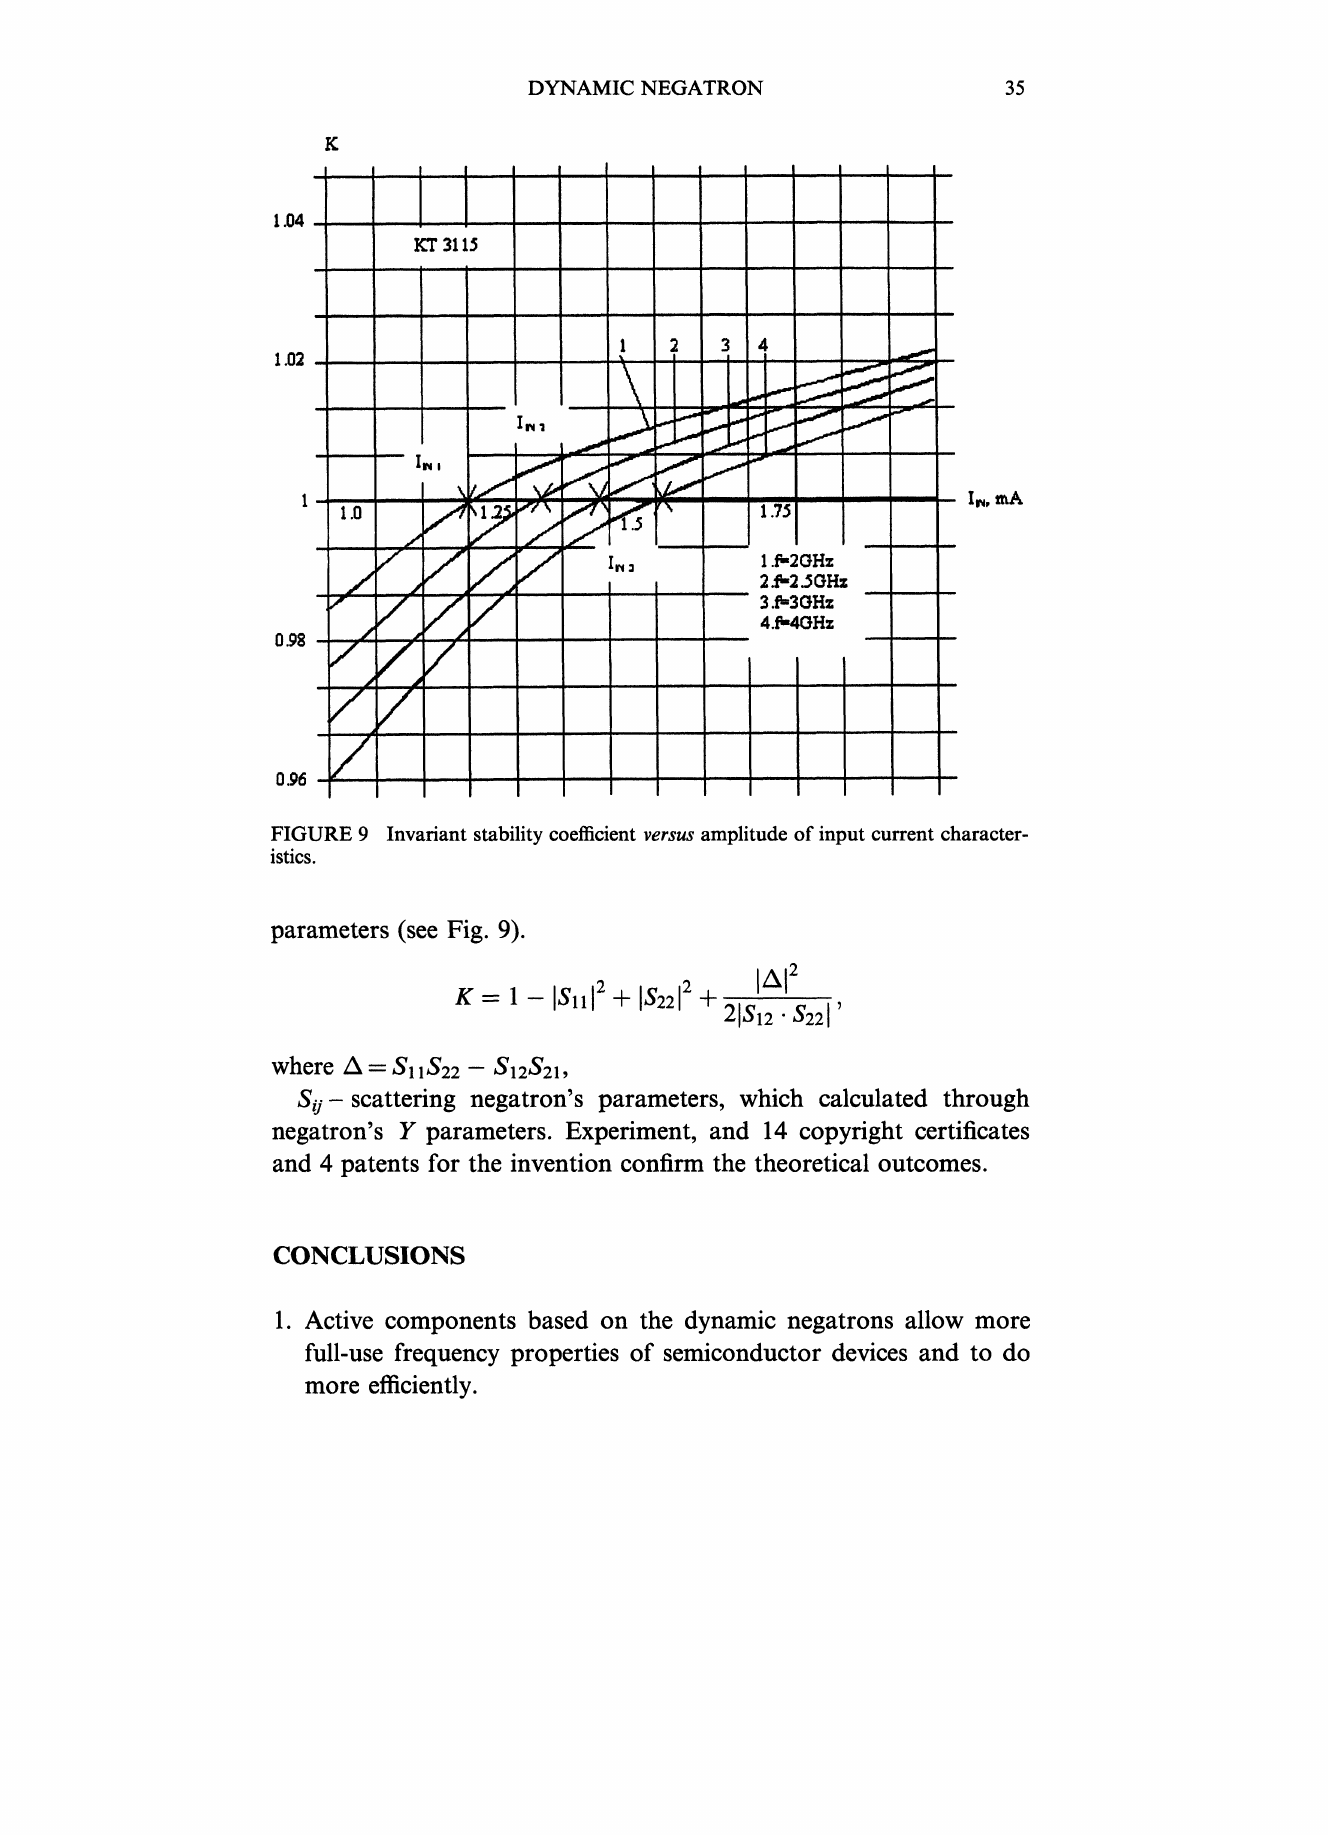
FIGURE 9 Invariant stability coefficient versus amplitude of input current character-